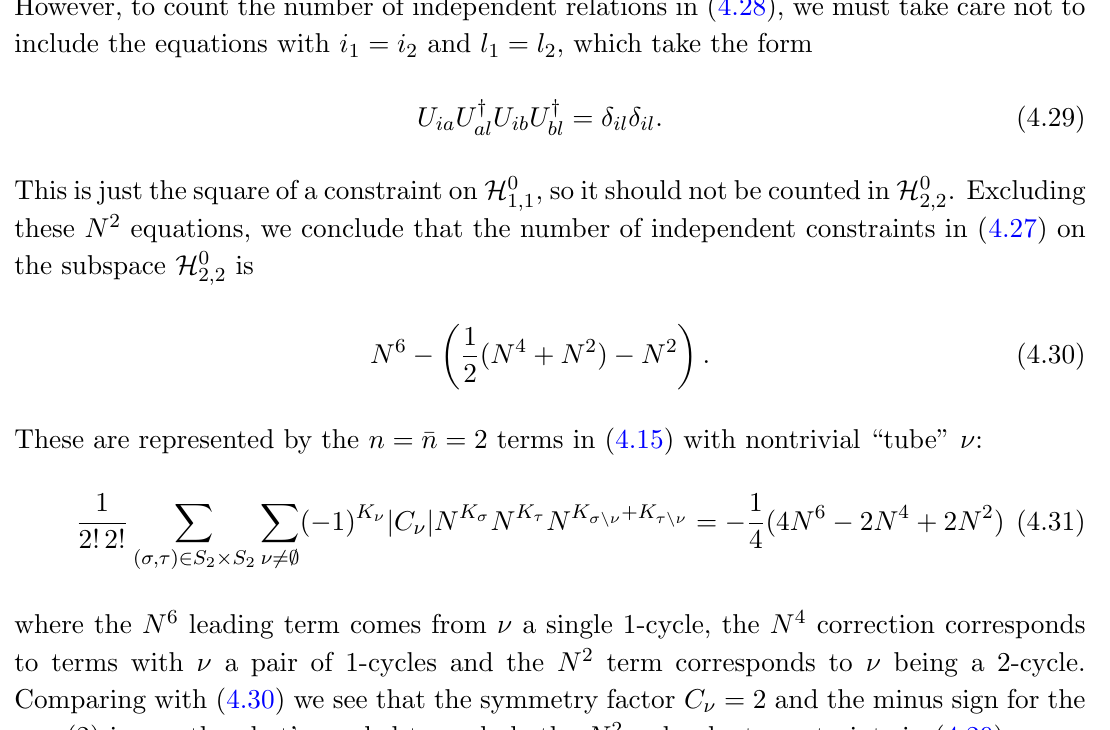
IJ U y KL . The diagram in the obtained by contracting a pair of right KL